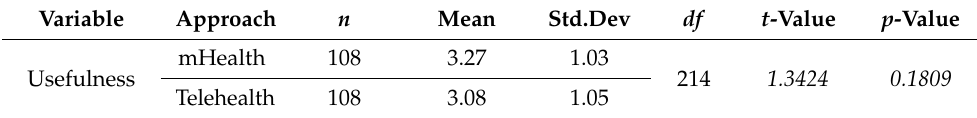
Table 11. Difference in Reliability of mHealth and Telehealth.